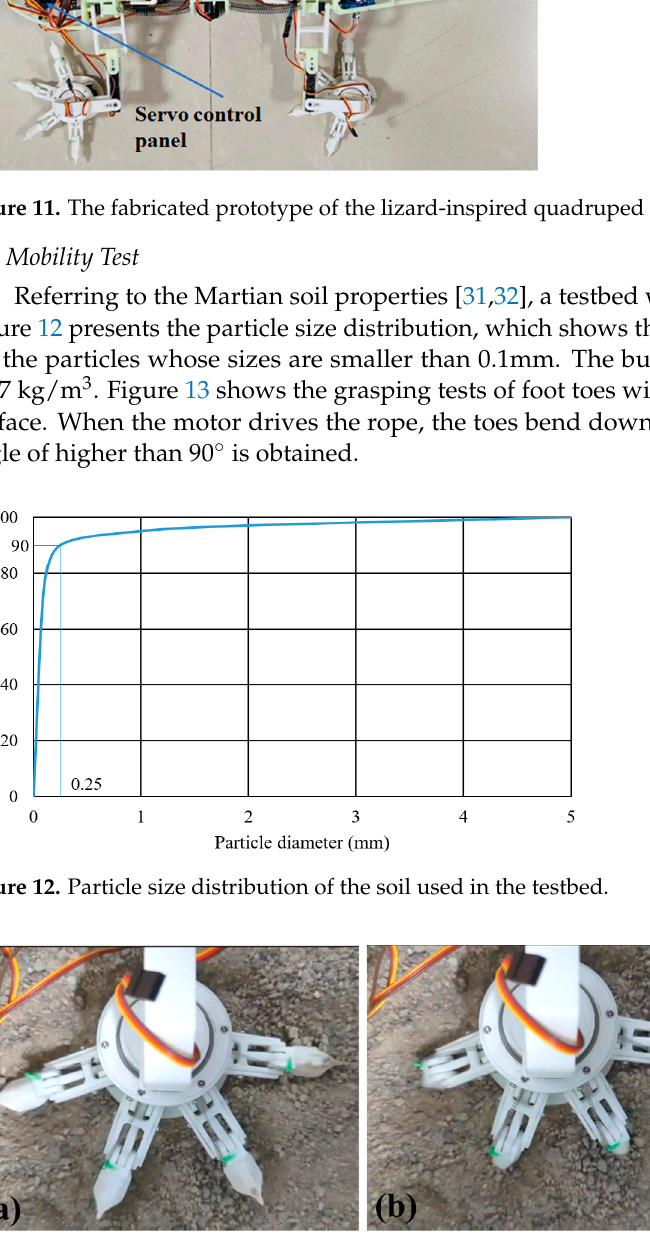
Figure 14. Moving on simulated Mars surface terrains. To further demonstrate that the robot is suitable for rocky environments, external tests were conducted and are shown in Figure 15. It can be identified that the left hind leg of the robot can climb across a rock, indicating that this improved robot model has better performance compared with the previous work [19]. Figure 15. Climbing over a rock on the simulated Mars surface terrains. 6. Discussion To explore geomorphology and conduct surface exploration on Mars with scientific instruments carried by a robot, this work evaluates a biomimetic creeping robot inspired